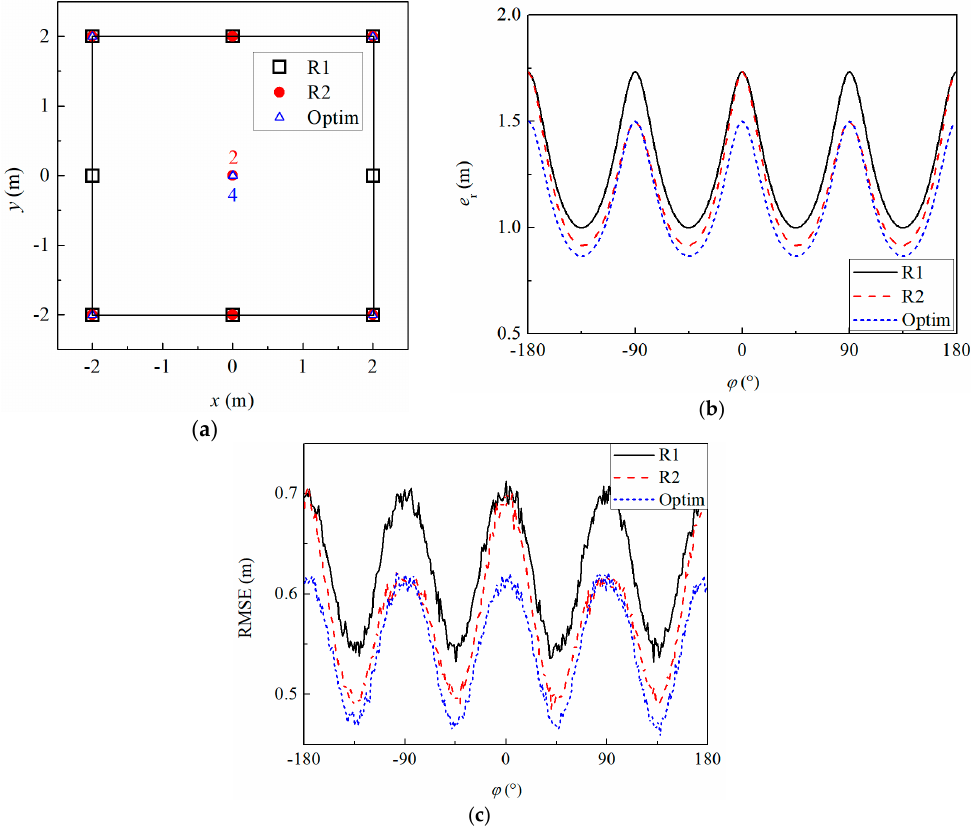
Figure 8. Comparison of optimized and reference arrays: ( a ) array deployment; ( b ) Cramér-Rao lower bound (CRLB) curve; ( c ) simulation of root-mean-square-error (RMSE).